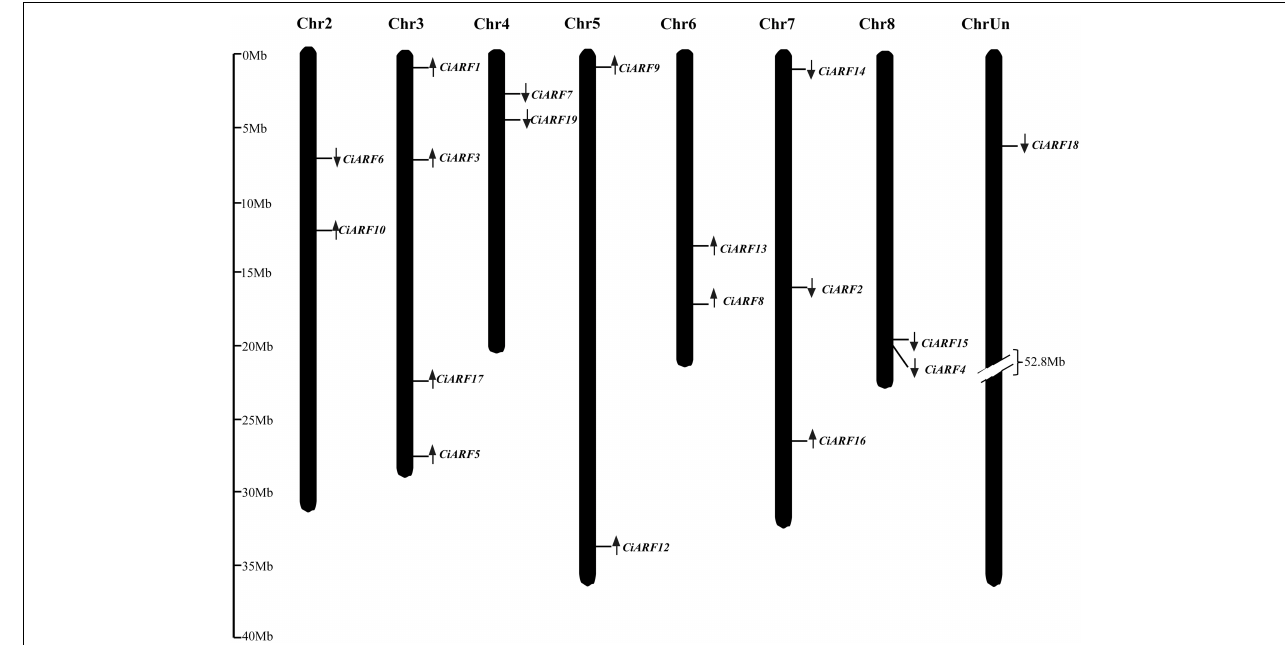
FIGURE 3 | Distribution of CiARF genes in sweet orange genome; the chromosomal position of each CiARF gene is mapped according to the sweet orange genome. The chromosome number is indicated at the top of each chromosome. The scale is in megabases